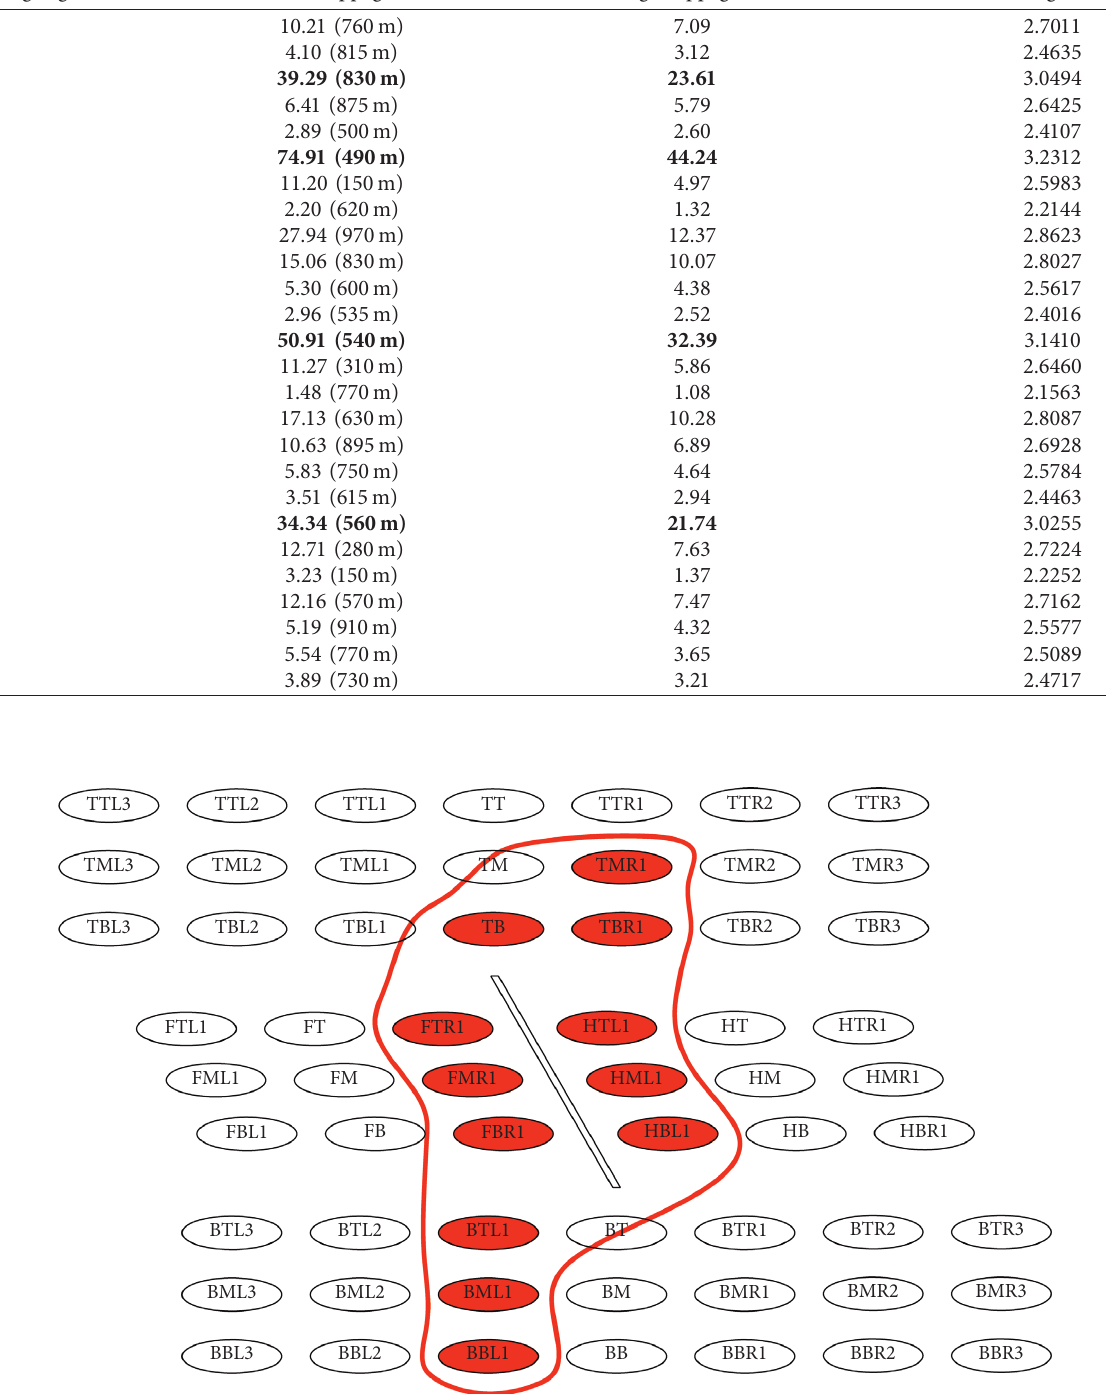
Figure 23: Hazardous injection area when the pressure was